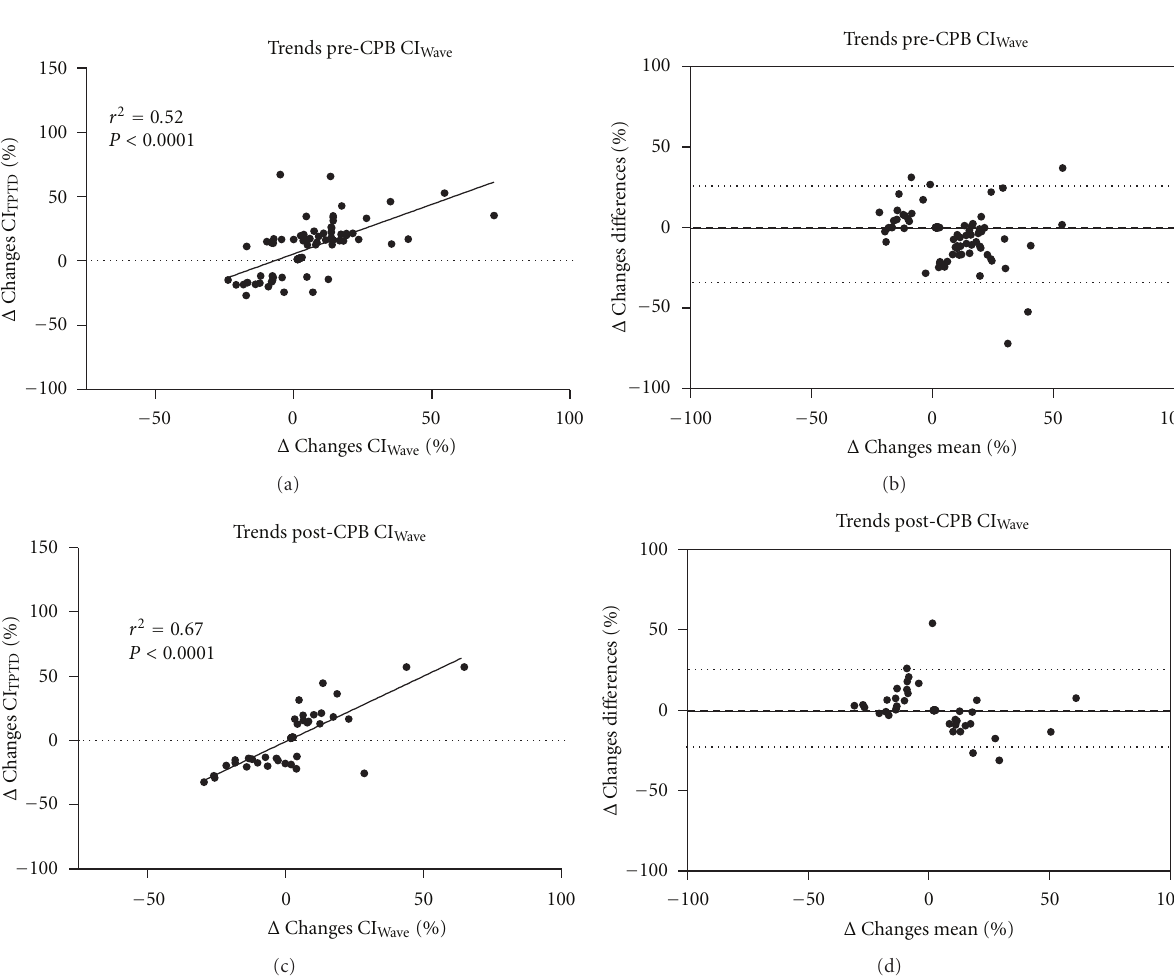
Figure 3: Correlation and Bland-Altman analysis of percentage changes in cardiac index measured by transpulmonary thermodilution ( Δ CI TPTD ) and cardiac index measured by uncalibrated semi-invasive pulse contour analysis ( Δ CI Wave ) before and after cardiopulmonary bypass